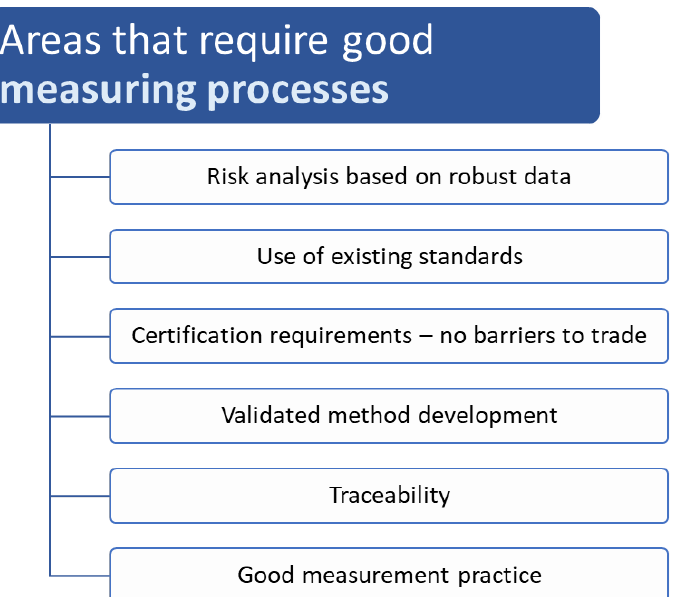
Figure 1. Examples of fields where the best possible measurements are especially relevant.